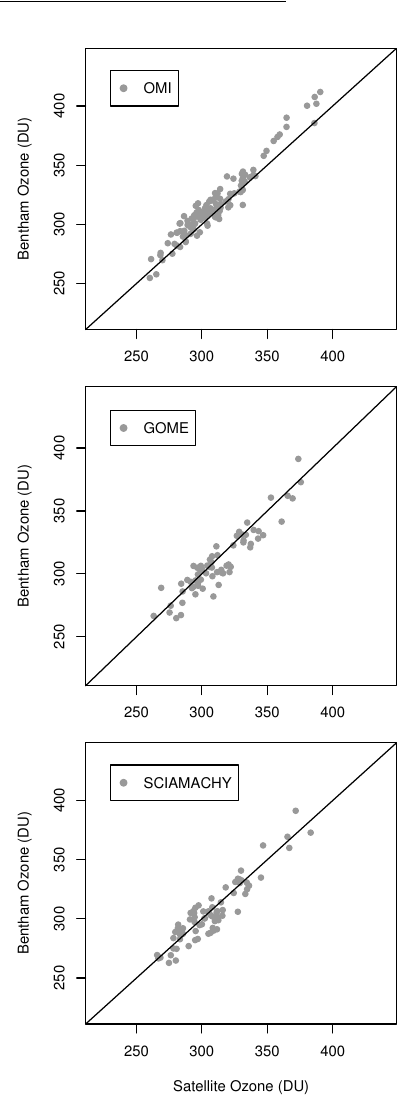
Fig. 4. Correlation between satellite and ground-based TOC data gathered over Granada for the period between April 2005 and May 2006. (top) OMI versus Bentham. (middle) GOME versus Bentham. (bottom) SCIAMACHY versus Bentham. The solid line represents the unit slope with which the data almost agree. DU, Dobson